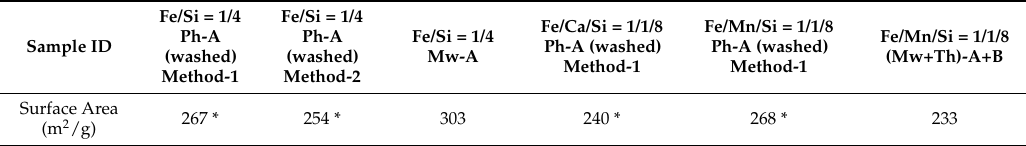
Table 4. Variation of surface area of photo ‐ catalyzed silica supported iron catalysts. See Section 3 for the notation of the sample identification.